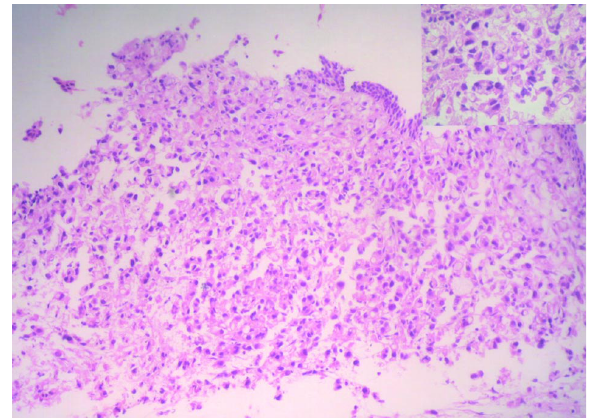
Figure 3 – Photomicrography showing infiltration of signet-ring cell adenocarcinoma in bladder wall (HE, X250), detail with mag- nification